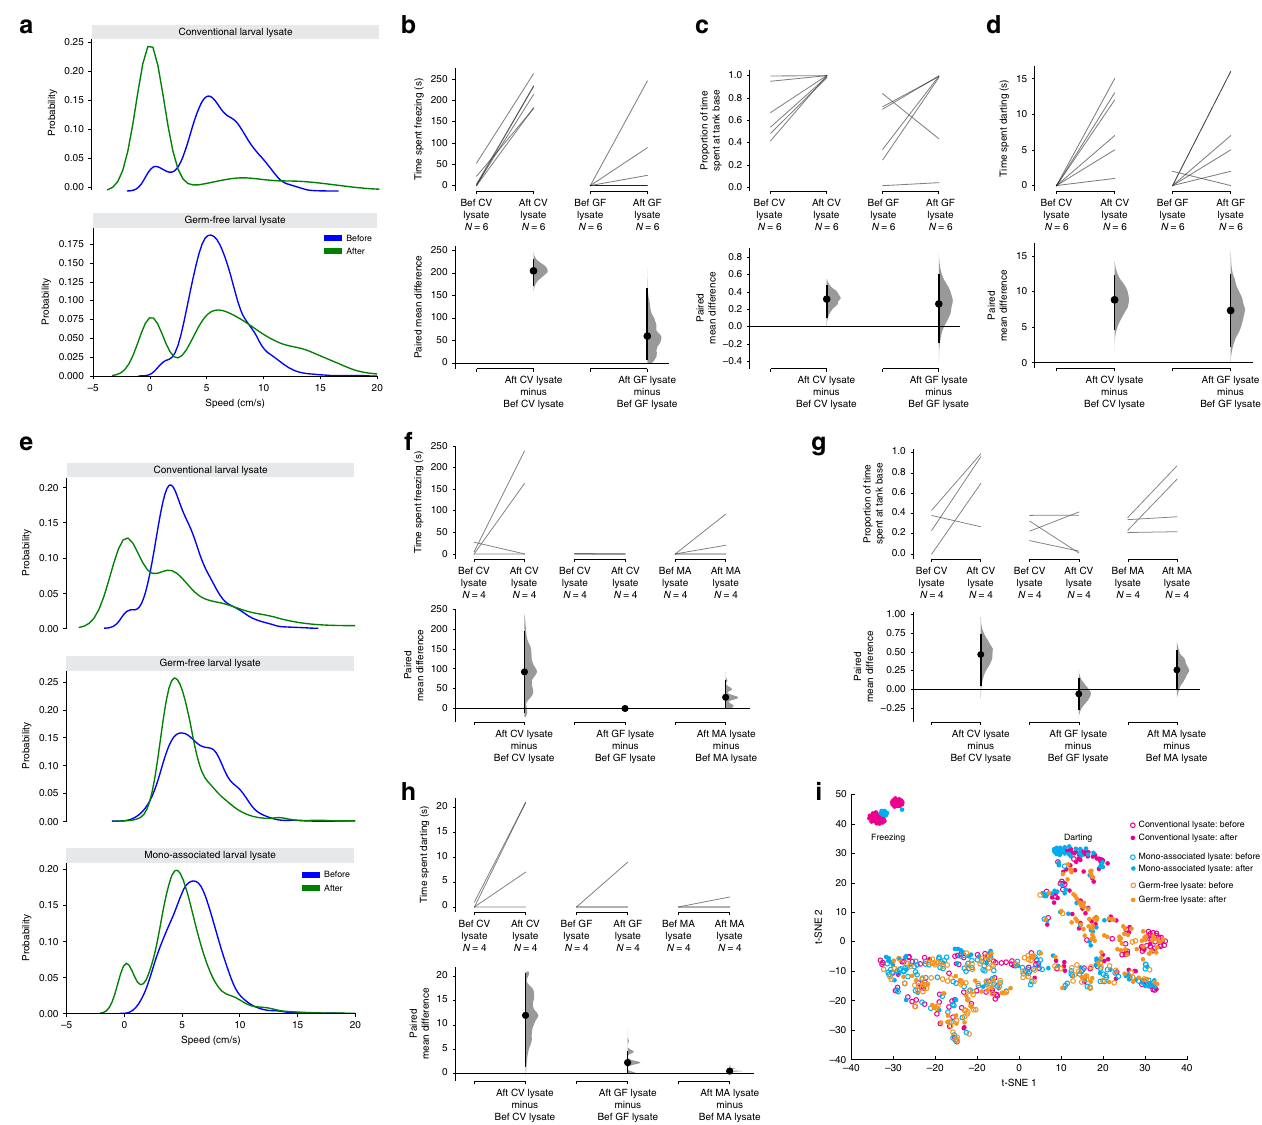
Fig. 6 Fish and bacteria provide components of the alarm substance. Effect of lysate from conventional (CV) and germ-free (GF) larvae on behavior of adult zebra fi sh ( n = 6 each), as shown by speed probability density function ( a ), and change in freezing ( b ), time spent at the tank base ( c ), and darting ( d ). e – h . Effect of lysate from a separate batch of conventional (CV), germ-free (GF), and monoassociated (MA) larvae on behavior of adult zebra fi sh ( n = 4 each). i Swimming behavior was clustered using t-distributed stochastic neighbor embedding (t-SNE). Each data point represents behavior within a 5 s epoch. Filled circles indicate behavior that occurs after delivery of the lysate. The response to lysate from conventional is monoassociated larvae (blue and red circles) are more similar than the response to lysate from germ-free larvae (orange circles). The cluster on the top left corner corresponds to prolonged freezing behavior, which was not evoked by lysate from germ-free fi sh. Other postlysate clusters may represent darting behavior 25× water dipping objective and the Ti Sapphire laser tuned to 930 nm. the substance was delivered and plotted in a histogram. The probability density Wide fi eld imaging was performed using a Zeiss Axio Examiner with a 20× water function for the before and after periods were superimposed to show the effect of dipping objective. Images were captured with a Hamamatsu Flash C4, con- the substance on fi sh speed. trolled by MetaMorph. Illumination was provided by a blue LED (Cairn). Larval For t-SNE-based clustering of behavior (MATLAB), eight features were fi sh were anesthetized in mivacurium, and then embedded dorsal up in 2% extracted from x – y coordinates: (1) Distance, (2) velocity, (3) acceleration, (4) agarose in E3 on a glass coverslip held in a Warner chamber. A wedge with an absolute tank depth, (5) change in tank depth, (6) horizontal translation, (7) angle of ~120 ˚ was cut in front of the fi sh, which was then placed within in a posture (i.e., width/height of bounding box), and (8) change in posture. The mean, diamond fl ow chamber (Warner R26). Stimuli were delivered using a perfusion minimum, maximum. and standard deviations of these features were then device (Warner VC-6M) controlled by TTL pulses from the Elements or quanti fi ed across 5s (150 frame) epochs for the entire length of the experiment MetaMorph software. (both before and after lysate presentation) and aggregated across 12 fi sh (four fi sh from each treatment of conventional, germ-free, and monoassociated fi sh Images were analyzed using FIJI software 66 . After registration to correct for x – y lysates, respectively) in an 8× 4 = 32 dimensional array. t-SNE was then applied drift, using the StackReg plug-in with the translation option, a running average of for dimensionality reduction to two dimensions (MATLAB default parameters: three frames was carried out. The change in fl uorescence intensity (F/F0) was then https://www.mathworks.com/help/stats/tsne.html). obtained, using the ten frames prior to stimulus delivery as a baseline. Images show the frame with the maximum increase in fl uorescence. For display, the “ fi re ” LUT was used, with level set to a center of 5.69 and width of 10.67 in all images. To compare the extent of OSN activation, the area of pixels with more than Calcium imaging . Two photons imaging at 1 Hz were carried out using a gal- twofold increase in fl uorescence was compared. The area of overlap between the vano scanner on a Nikon A1R-MP system attached to a FN1 microscope with a NATURE COMMUNICATIONS| (2019) 10:3831